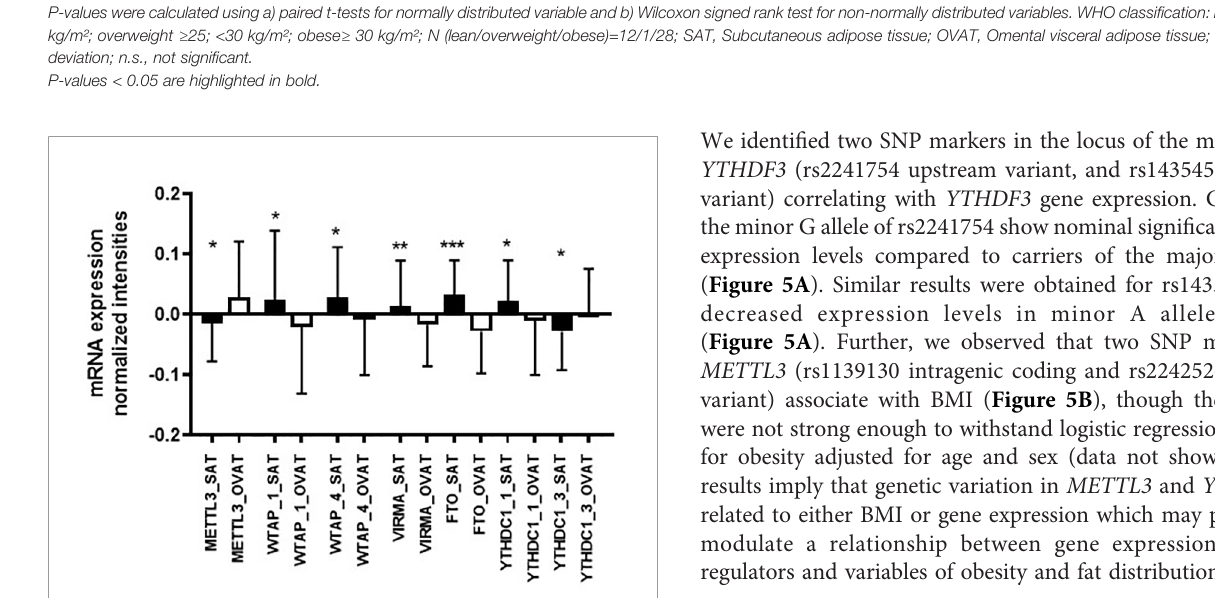
FIGURE 2 | Adipose tissue depot-speci fi c differences in gene expression of m6A writers, reader and erasers (adipose tissue Leipzig cohort). Differences in gene expression (log transformed, normalized intensities) between SAT and OVAT. Data are presented as mean ± SD. P -values were calculated using paired samples t-tests or Wilcoxon signed rank test in n=41 and given as asterix (*P < 0.05; **P < 0.01; ***P < 0.001). OVAT, omental visceral adipose tissue; SAT, subcutaneous adipose tissue. The following Illumina probes are presented: METTL3=ILMN_1655635;